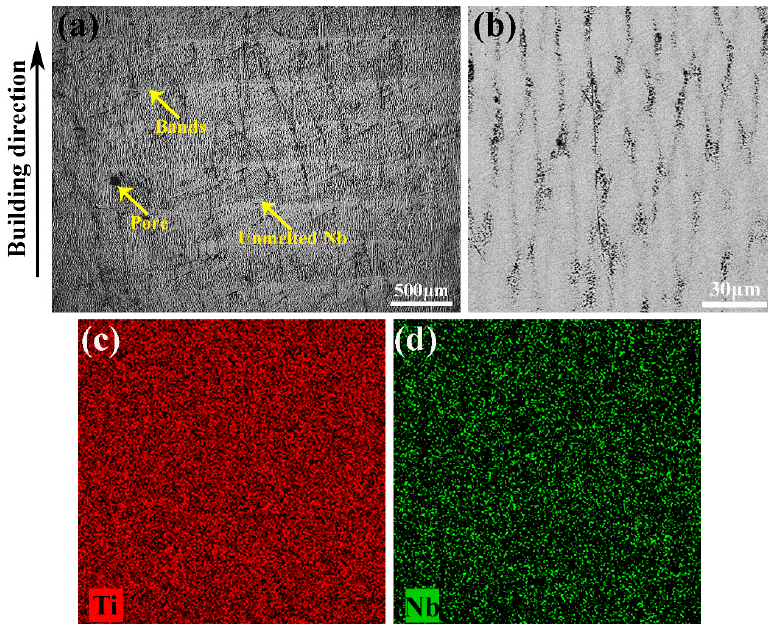
Figure 5. ( a ) and ( b ) Microstructures of as-deposited Ti–26Nb alloy; ( c ) and ( d ) elemental mapping images of as-deposited Ti–26Nb of ( b